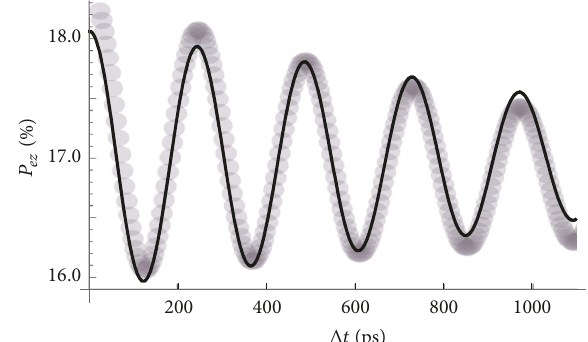
Figure 5: The spin polarization calculated in Ref. [28] (gray circles) and our results (black curve), to first order of the interaction picture, for level density 𝜌 𝜐 (𝜀) = 10 9 𝜖 𝑠 , with 𝑠 = 0.36 , and frequency 𝜔 𝑜 = 2.73556 × 10 10 s −1 . The gray circles graph published with author’s permission.